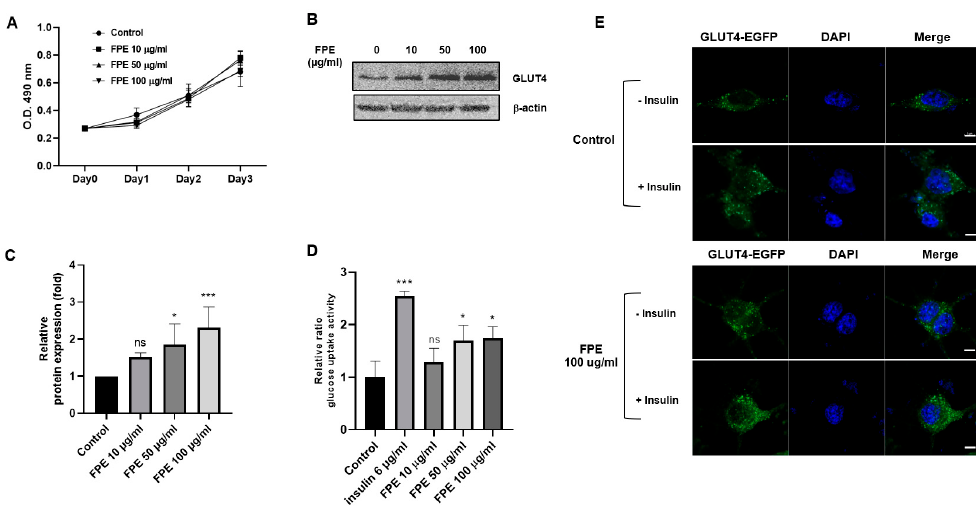
Figure 3. Effect of FPE on L6 myocytes. ( A ) L6 cells treated with 10, 50, and 100 μ g/mL FPE showed no significant toxicity at 0, 24, 48, and 72 h post treatment. ( B ) Western blotting showed a dose-dependent increase in GLUT4 protein expression in rat L6 myocytes treated with increasing concentrations of FPE for 24 h. ( C ) The bar graphs represent the relative protein expression levels of GLUT4 after normalization to β -actin. Results are shown as mean ± SEM; n = 3, ns, not significant; * p < 0.05, *** p < 0.001. ( D ) Glucose oxidase assay was performed to quantitate the amount of glucose consumption in differentiated L6 myocytes treated with 6 μ g/mL insulin and 10, 50, and 100 μ g/mL FPE. The results indicated that the glucose uptake ability was significantly higher in cells treated with 50 and 100 μ g/mL FPE but not significantly different in cells treated with 10 μ g/mL FPE compared to untreated cells. n = 3, * p < 0.05, *** p < 0.001. ( E ) Effects of FPE on GLUT4 trafficking, compared to negative control and insulin as positive control. GLUT4-EGFP plasmid (green) was transiently transfected into L6 myocytes and co-treated with 100 nM insulin and 100 μ g/mL FPE for 24 h. The cells were then fixed with 4% paraformaldehyde and the nuclei (blue) were stained with 1 μ g/mL DAPI and examined using a confocal microscope. Scale bar = 5 μ m.